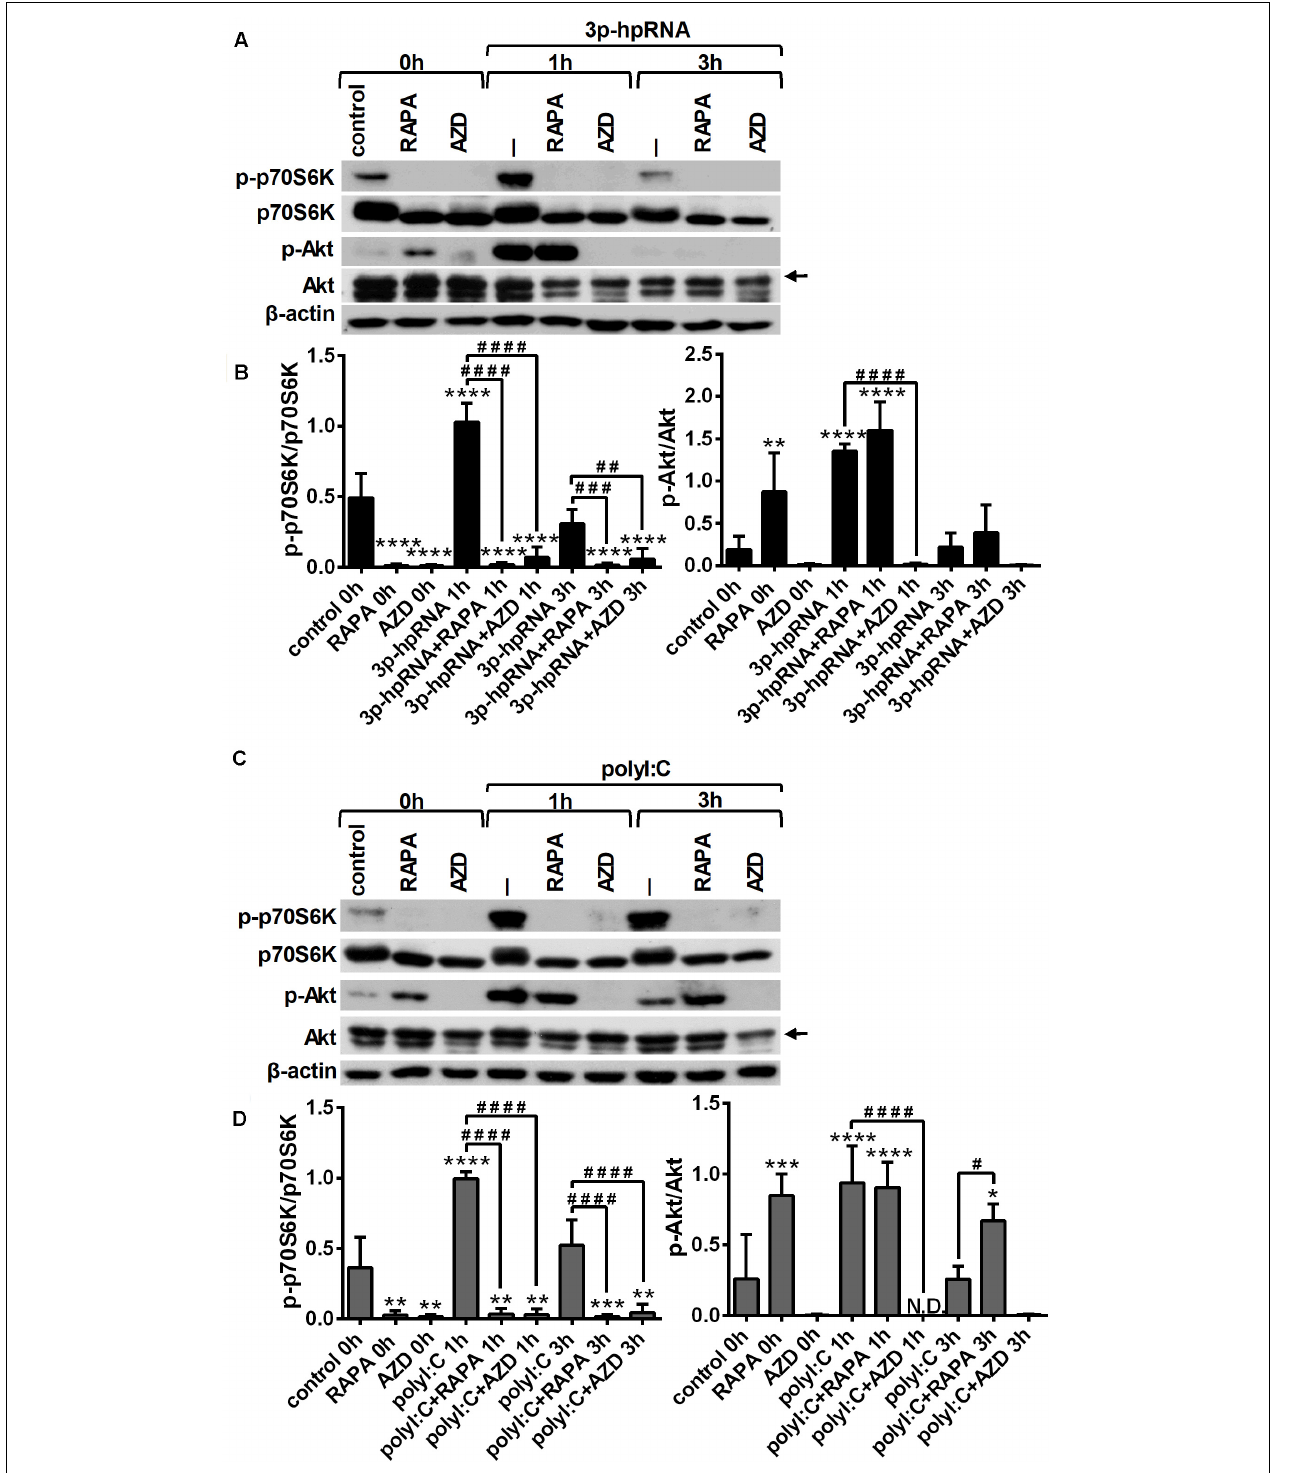
FIGURE 5 | RLR stimulation increases mTORC1 and mTORC2 activity in GEN2.2 cells that can be effectively inhibited by rapamycin and AZD8055 pre-conditioning. GEN2.2 cells were pre-treated with vehicle control, 100 nM rapamycin (RAPA) or 100 nM AZD8055 (AZD) for 2 h and then stimulated with 3p-hpRNA (0.5 µ g/ml) (A,B) or polyI:C (1 µ g/ml) (C,D) in a time-dependent manner. Kinetics of p70S6K and Akt phosphorylation was determined by western blotting. (A,C) Representative blots are shown. (B,D) Bar graphs represent the mean ± SD from 4 independent experiments. Specific bands for Akt are indicated by arrows. * p < 0.05, ** p < 0.01, *** p < 0.01, **** p < 0.0001 vs. control; # p < 0.05, ## p < 0.01, ### p < 0.001, #### p < 0.0001. ND, not